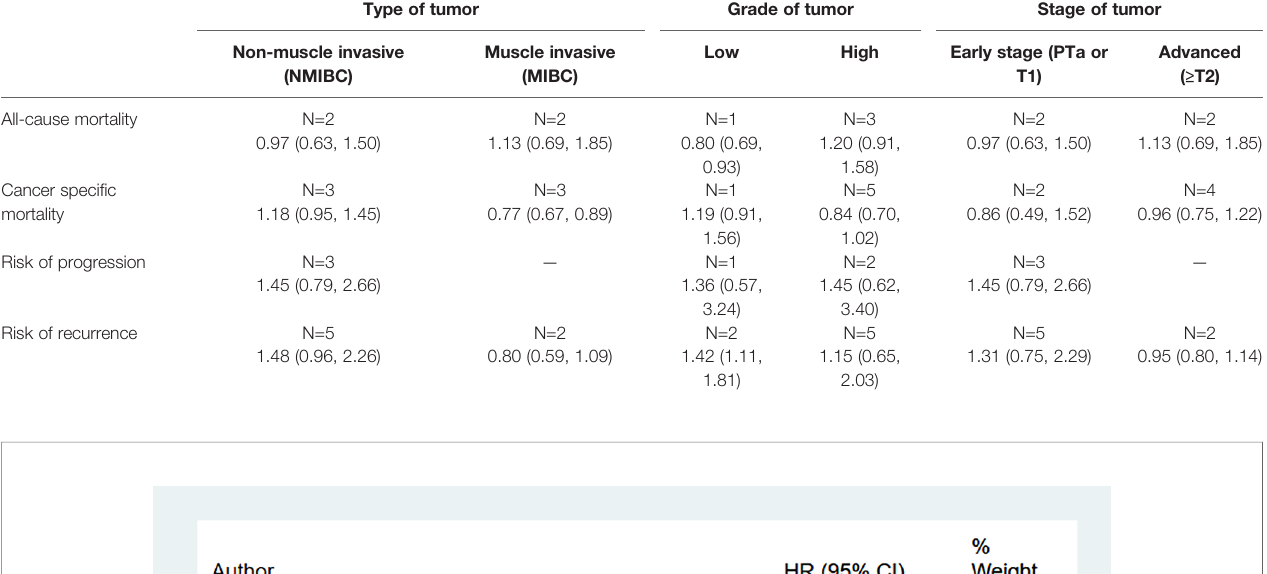
TABLE 2 | Subgroup analysis for bladder cancer outcomes in overweight patients relative to normal BMI.